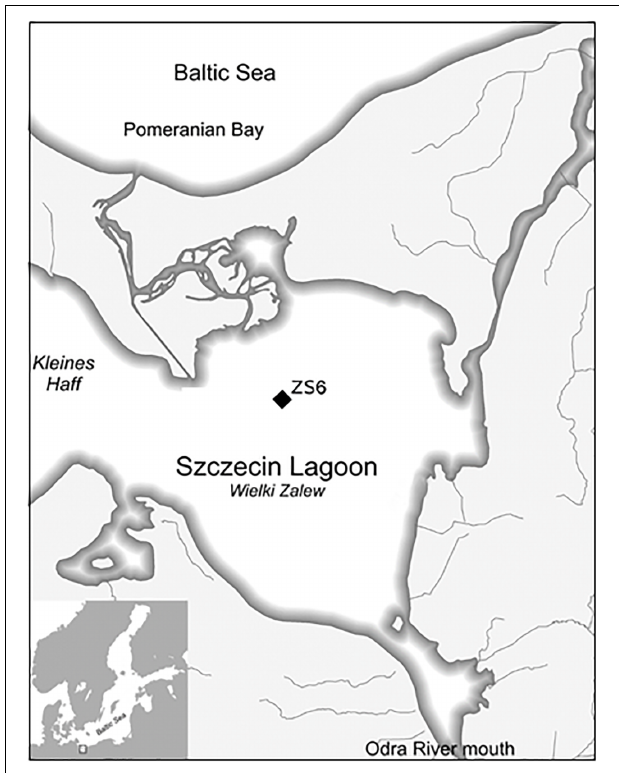
FIGURE 1 | Area of study and location of sampling station in the Szczecin